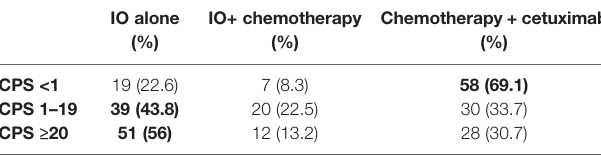
Most frequent answers in the different PD-L1 CPS groups are depicted in bold.